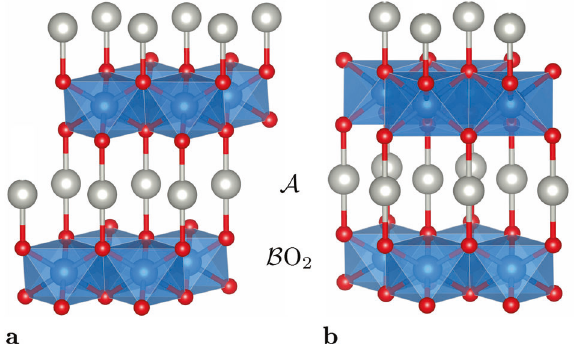
Fig. 1 Delafossite AB O 2 crystal structure. ( a ) R 3 m and ( b ) P 6 3 / mmc symmetry. A (grey), B (blue) and O